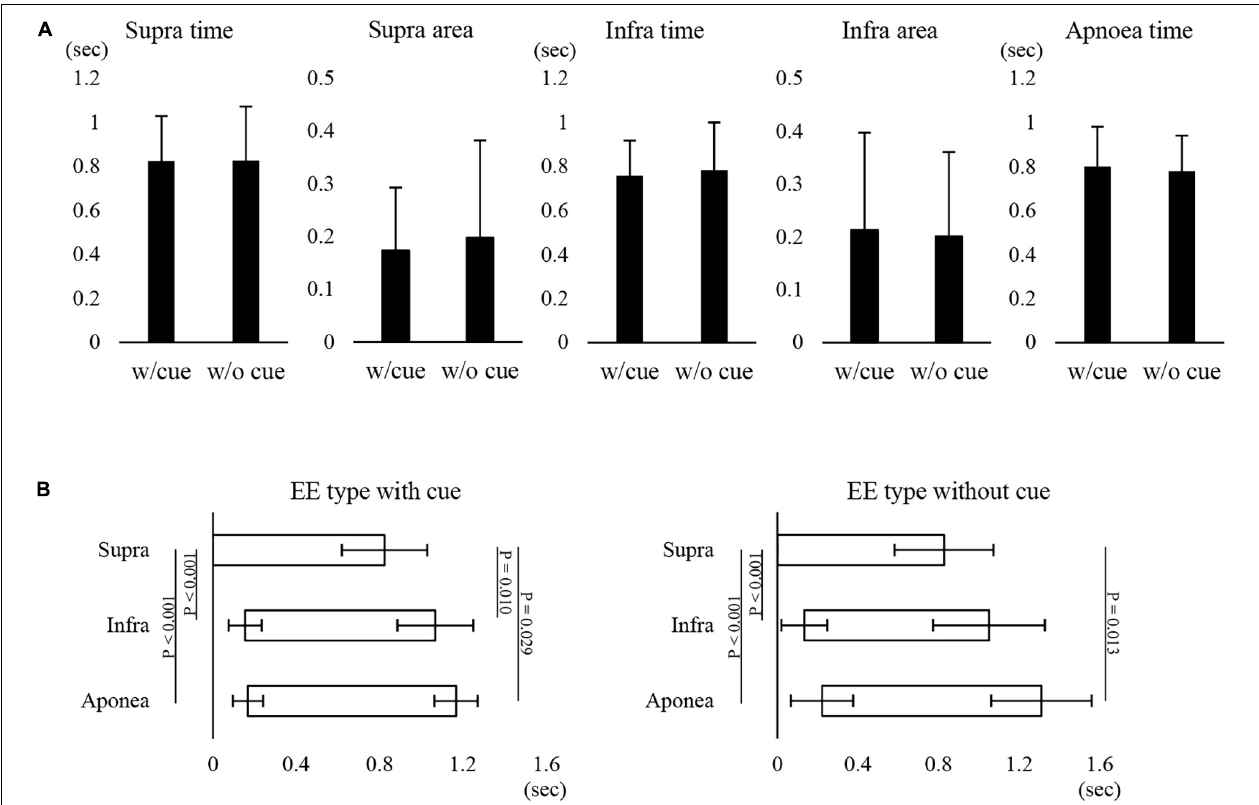
FIGURE 3 | Effect of cueing on 3-ml water swallowing behaviors in EE type. (A) There were no differences in the suprahyoid (Supra) electromyography (EMG) burst duration (Supra time) or area (Supra area), infrahyoid (Infra)EMG burst duration (Infra time) or area (Infra area), or swallowing apnoea time between with (w/cue) and without cue (w/o cue) (Student’s t -test). (B) In the with (left) and without cue (right) conditions, onset and offset of Supra EMG burst were followed by those of Infra EMG burst and swallowing apnoea (Apnoea) (one-way repeated measures ANOVA followed by Tukey test for onset with cue, P < 0.001, df = 2, F = 34.876; one-way repeated measures ANOVA on ranks followed by Tukey test for offset with cue, P = 0.004; one-way repeated measures ANOVA followed by Tukey test for onset without cue, P < 0.001, df = 2, F = 14.624; one-way repeated measures ANOVA on ranks followed by Tukey test, P =